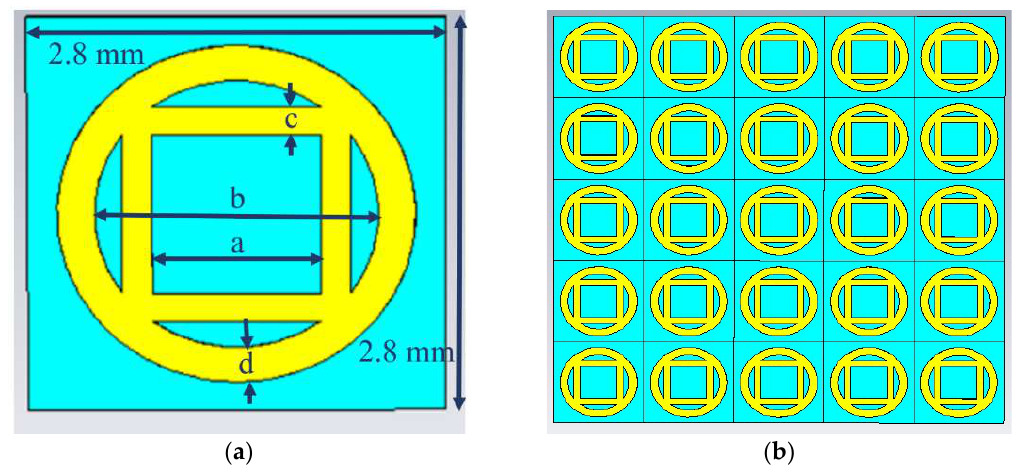
Figure 2. The geometry of the proposed 60 GHz flexible metasurface in simulation ( a ) simulated unit-cell with the dimensions, ( b ) A 5 × 5 unit-cell segment displayed from the infinite metasurface array.